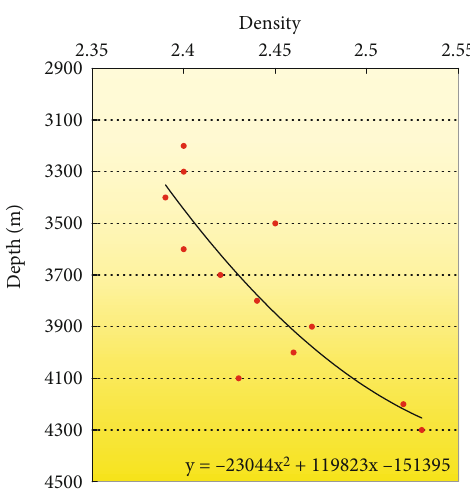
Figure 9: Porosity vs. depth.